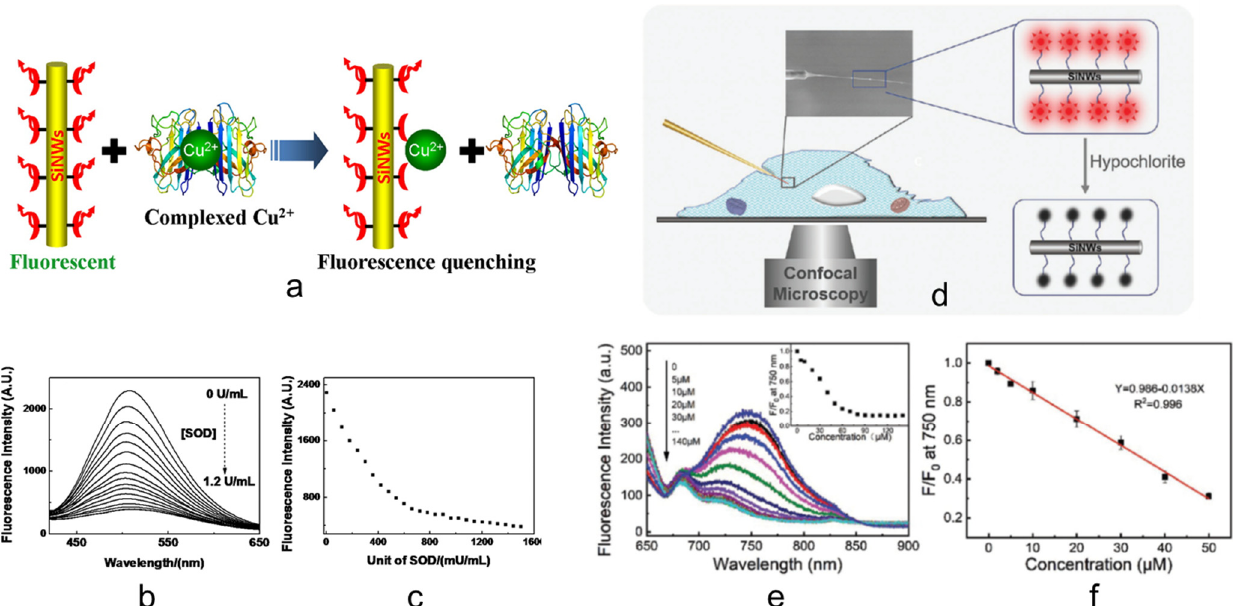
Figure 2. ( a ) Working principle of the Si NW fluorescent sensor for the detection of Cu 2+ [60]. ( b ) Fluorescence spectra of the Si NW sensor acquired for different concentrations of SOD1 [60]. ( c ) Dose-response curve in terms of fluorescence as a function of mU/mL of SOD1 for the Cu 2+ detection by the Si NW fluorescent sensor [60]. ( d ) Schematic representation of the HCL fluorescent sensor based on the use of a single Si NW on the tip of a micropipette [34]. ( e ) Fluorescence spectra obtained for different concentrations of HCl. In the inset to e) the complete calibration curve obtained is reported [34]. ( f ) Part of the dose calibration curve where the response can be fitted by a linear trend [34]. ( a – c ) are reproduced with permission [60], Copyright 2014, American Chemical Society. ( d – f ) are reproduced with permission [34], Copyright 2018, WILEY-VCH.